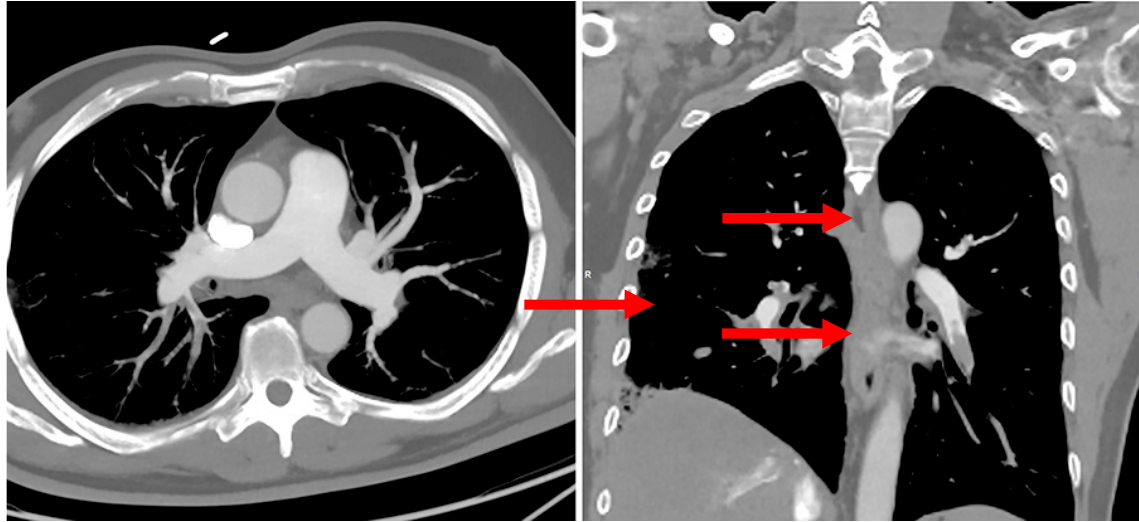
Figure 8. Left side: Transverse view of both pulmonary arteries after the thrombectomy showing no central thrombotic material. Right side: Coronal view showing only minor residual subsegmental thrombotic material (arrows).